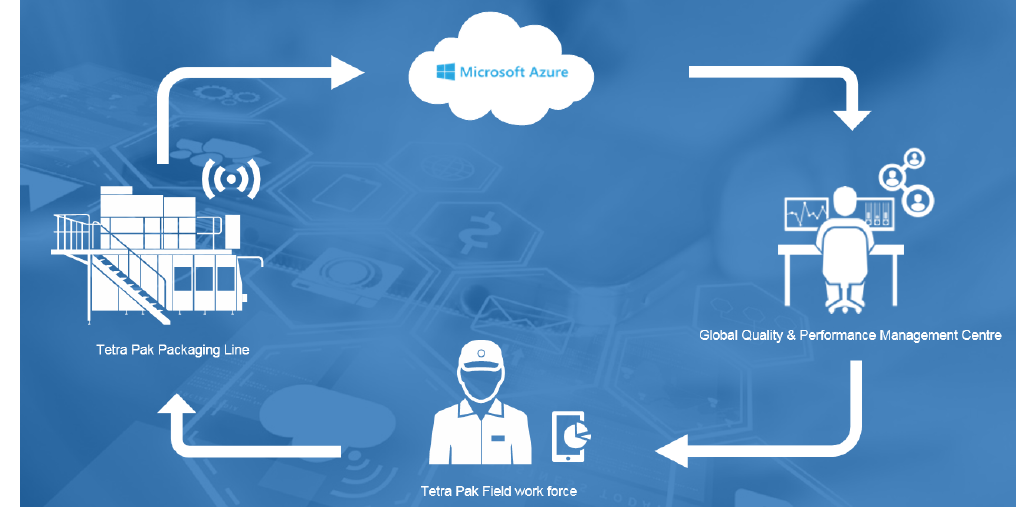
Figure 1. Outline of condition-monitoring